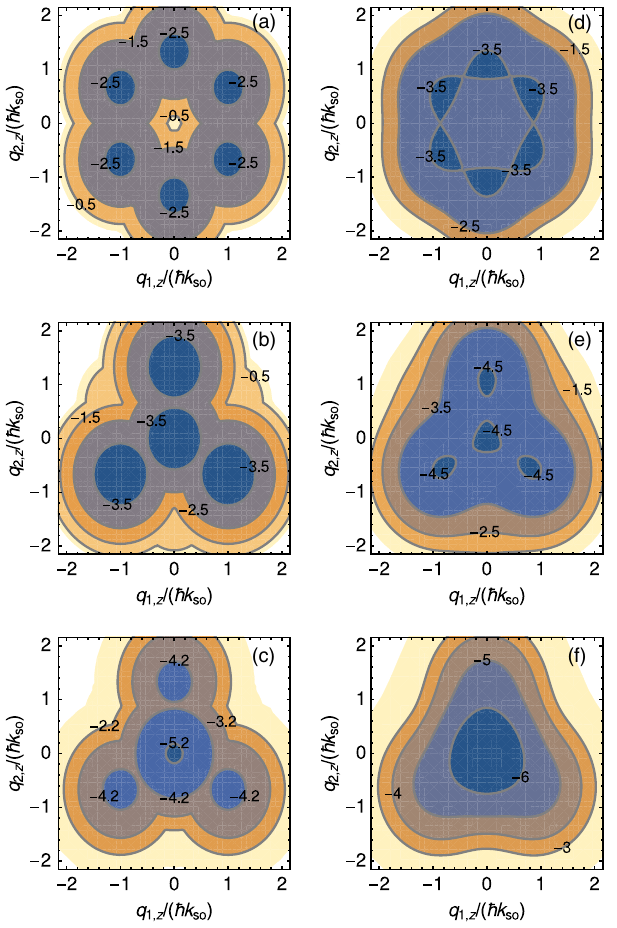
FIG. 4. Lowest noninteracting relative three-atom dispersion curve. The contours show the lowest noninteracting relative three-atom dispersion curve, in units of E , as functions of so ¼ 0 and ˜ δ =E ¼ 0 , 8 = 3 , and 3.5, q 1 and q 2 . (a) – (c) Ω =E ;z ;z so so ¼ 2 and ˜ δ =E ¼ 0 , 2.278, and 4, respectively. (d) – (f) Ω =E so so respectively.